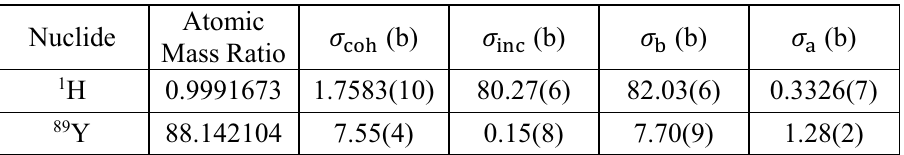
Figure 5. Total Scattering Cross Section for New (solid) and ENDF/B-VIII.0 (dashed) Y-YH Evaluations Calculated by NDEX Table I. Bound Scattering Cross Sections